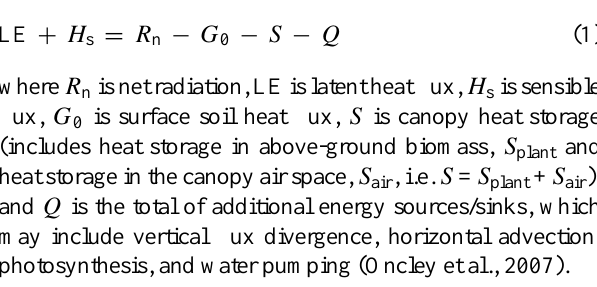
outgoing shortwave radiation, and upward and down- ward pyrgeometers for incoming and outgoing long- wave radiation. Signals are also recorded to a Camp- bell CR23X data logger at 2-second intervals, and av- eraged over 30-min for output data. The installation height of this system is 1.5